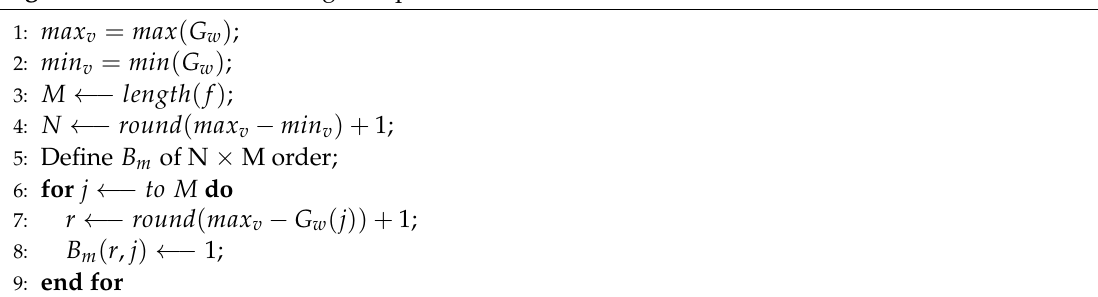
Algorithm 1 Generate the magnetic pattern